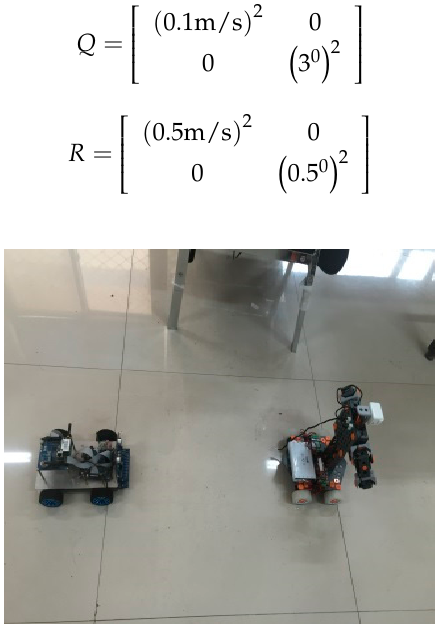
Figure 2. Experimental setup used for testing the proposed algorithm.